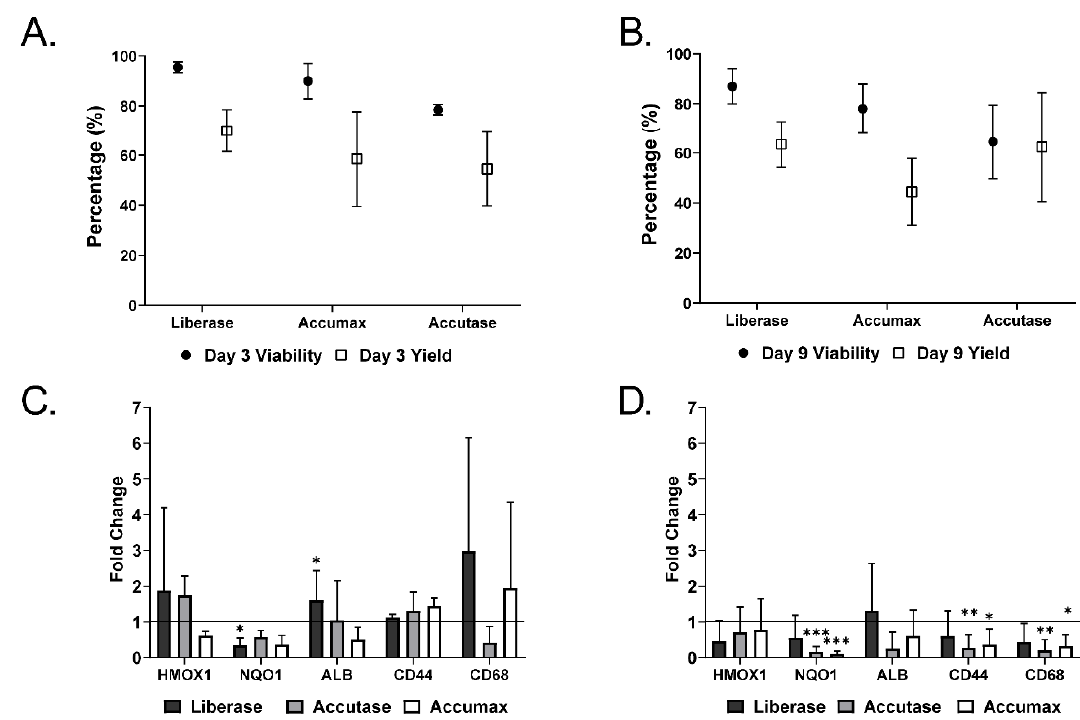
Figure 1. Graphical representation of experimental methodology with corresponding timelines. Human liver microtissues (MTs) are generated using HepaRG, hTERT-HSC, and THP-1. Initial experiments focused on optimization of dissociation using Liberase, Accutase and Accumax by comparing yield and viability. After dissociation, cells were suspended in 96 well plates to assess the maintenance of crucial cellular characteristics: HepaRG were able to release albumin; hTERT-HSC were able to become activated upon exposure to TGF- β1 ( A ). The optimized dissociation protocol was used to dissociate TGF- β1 treated and untreated MTs for processing following the single cell sequencing workflow ( B ).